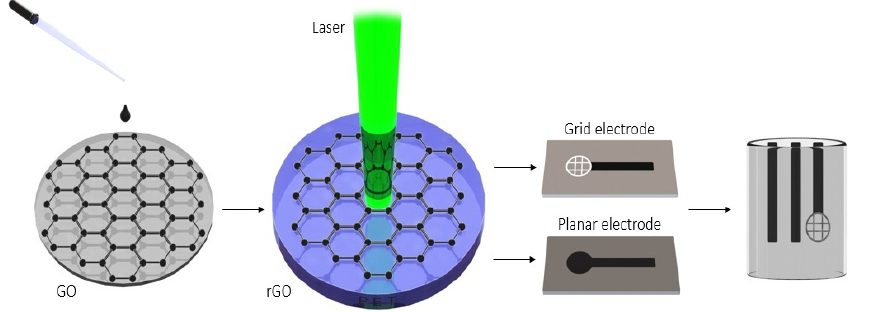
Figure 10. Schematic illustration of the fabrication of laser reduced graphene oxide electrode for the determination of carbaryl.